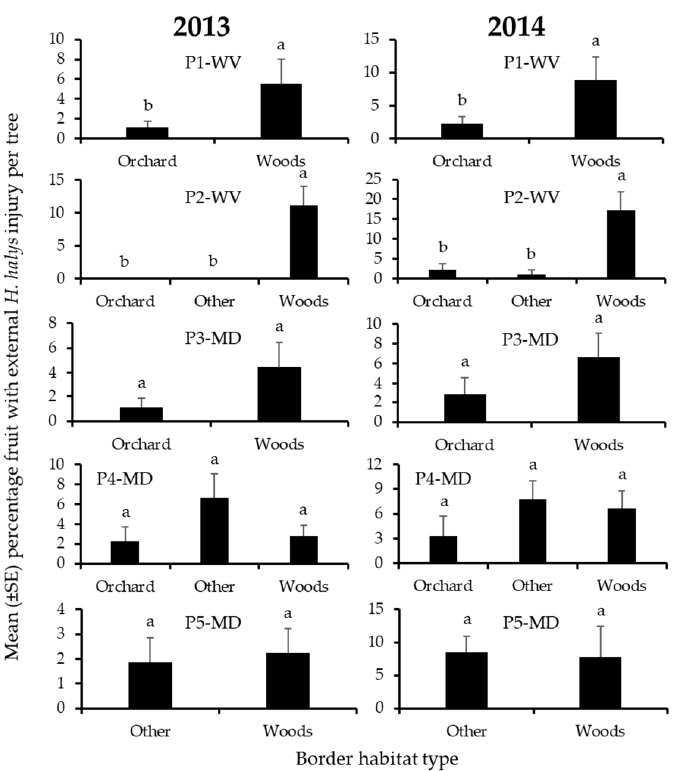
Figure 9. Mean (± SE) incidence of H. halys external injury to peaches per tree at harvest in 2013 (left) and 2014 (right), from trees on the perimeter of 5 peach orchard blocks in the Mid-Atlantic, USA, that were bordered by various habitats. Bars with shared letters are not significantly different (Tukey HSD, α = 0.05).